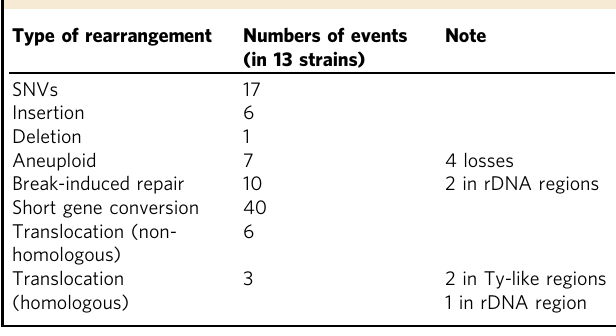
Fig. 1 DSB formation by heat-activated TaqI. a Schematic diagram of the TAQing system. A TaqI-expression vector was introduced into yeast cells, followed by transient heat activation of TaqI (inactive, blue circle; active, red circle) to generate DSBs in vivo. Red and blue ovals represent homologous chromosomes. b Cu 2 + -induced TaqI-expression analysis in haploid (YPH499) cells. An arrowhead indicates TaqI protein. c Immunodetection of DSB- induced Rad53 and Rad9 band shifts. Arrowheads indicate the phosphorylated forms of Rad53 and Rad9. d Chromosome-break analysis by pulse- fi eld gel electrophoresis (PFGE). e Cell viability after TaqI activation in haploid cells ( n = 5). dTaqI; dead (inactive) TaqI mutant. f Cell viability after TAQing in haploid and diploid cells ( n = 5). Mock; no CuSO 4 and no heat activation. g Homologous recombination rate at arg4-nsp / arg4-bgl heteroalleles in diploid (MJL1720) cells. h Loss-of-heterozygosity frequency of the ADE2 marker in fused diploid (WT14) cells. Data represent the mean ± SEM. *** P < 0.001; Welch ’ s t -test. i PFGE analysis of chromosome sizes in TAQed diploid strains exhibiting altered cell morphologies. Arrowheads indicate chromosomes with size difference. Chromosome number is shown on the left